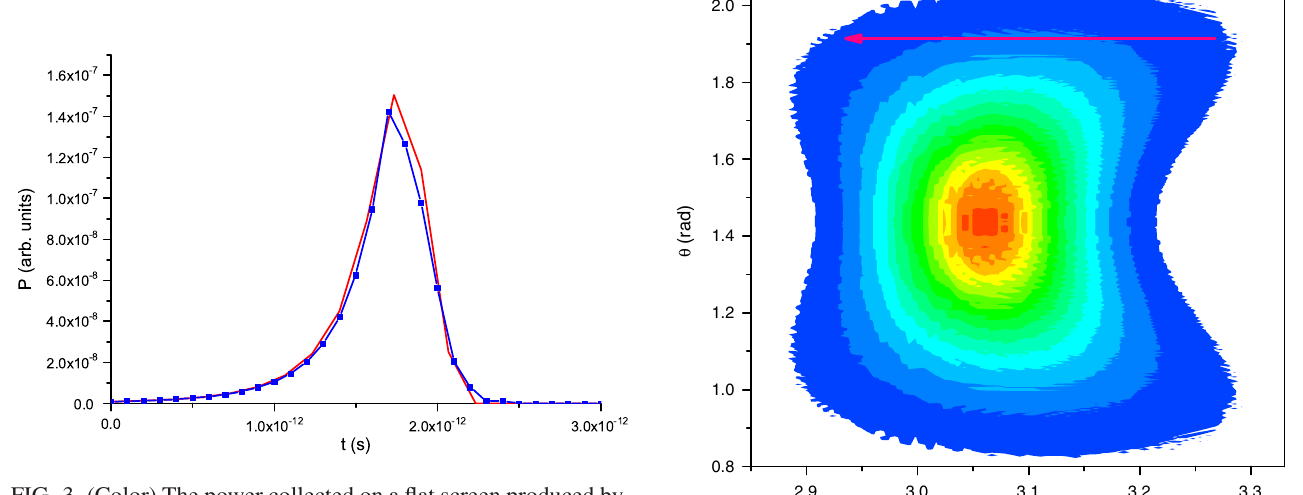
FIG. 3. (Color) The power collected on a flat screen produced by a single charge under the effect of a constant electric field as calculated by RETAR (blue dotted line) compared to the result of Sec. IV B (red line).